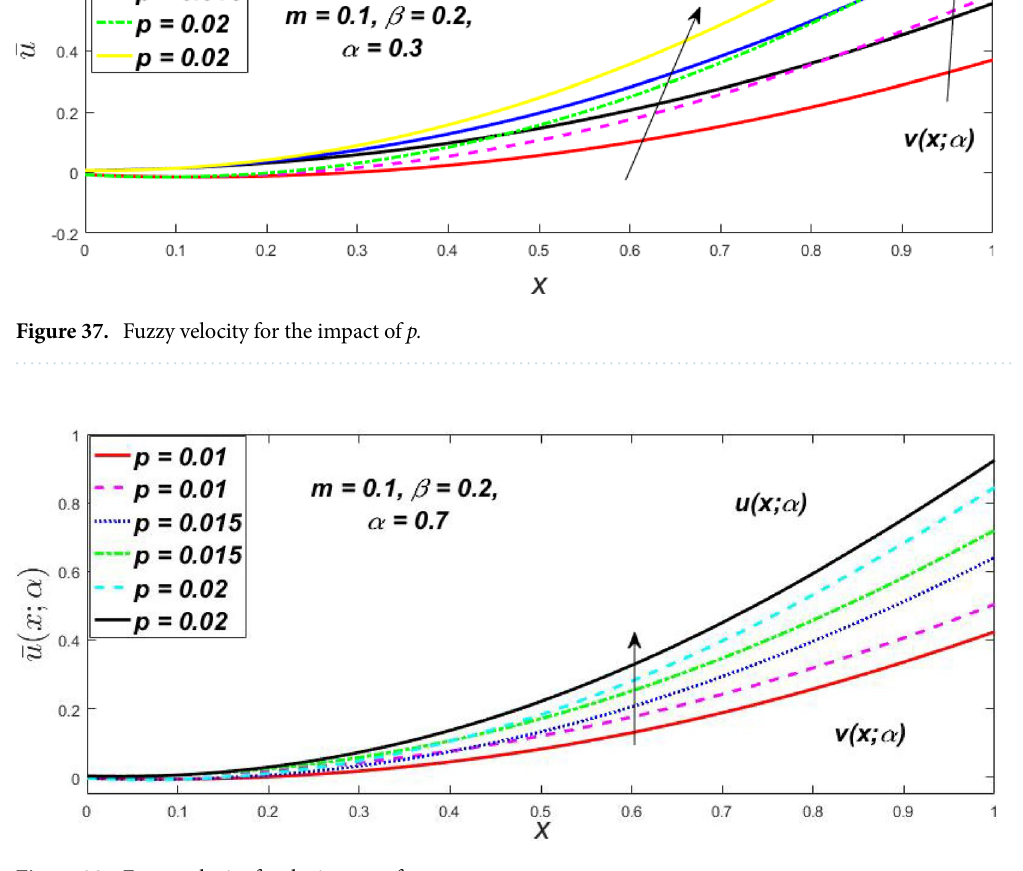
Figure 38. Fuzzy velocity for the impact of p.